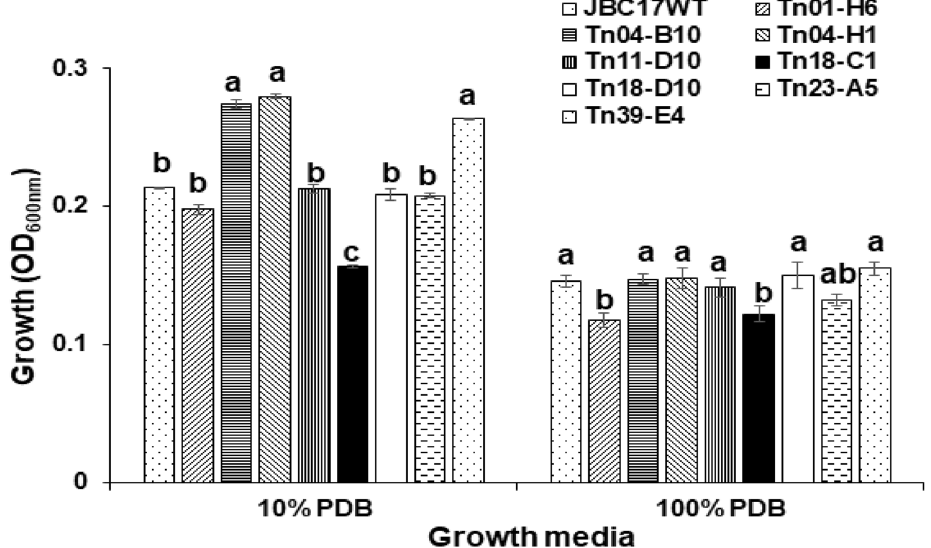
Figure 4. Comparison of growth rate of Pseudomonas putida JBC17 and its mutants in nutrient-rich and -poor media. The bacterial cells (OD 600 = 0.05) were inoculated into the fresh nutrient-limited (10% PDB) and -rich (100% PDB) media and incubated at 28 °C with shaking at 180 rpm. Growth was compared to that of the wild type 12 h and 24 h after incubation for 100% PDB and 10% PDB, respectively. The data represent the mean ± standard deviation of the replications, and the same letters indicate a non-significant difference at P < 0.05 according to Tukey’s